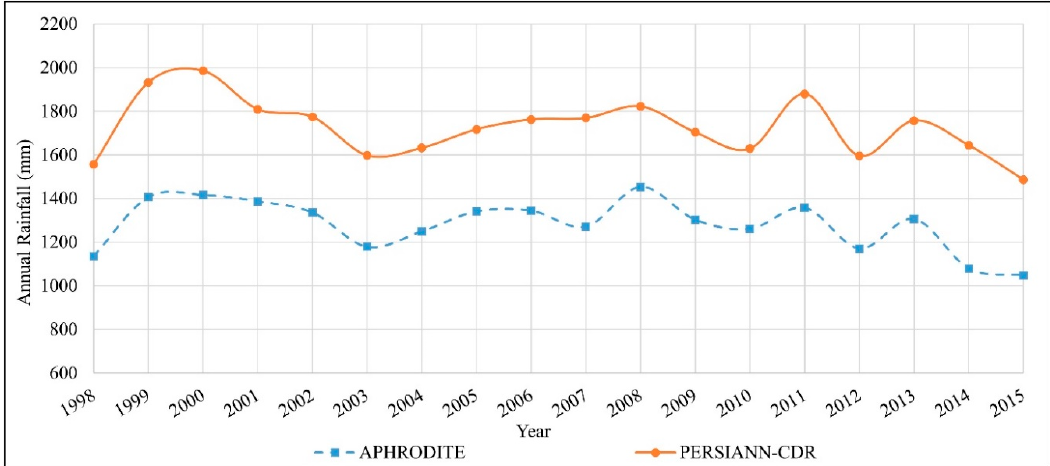
Figure 3. Mean annual rainfall of the Mekong River basin from 1998 to 2015.